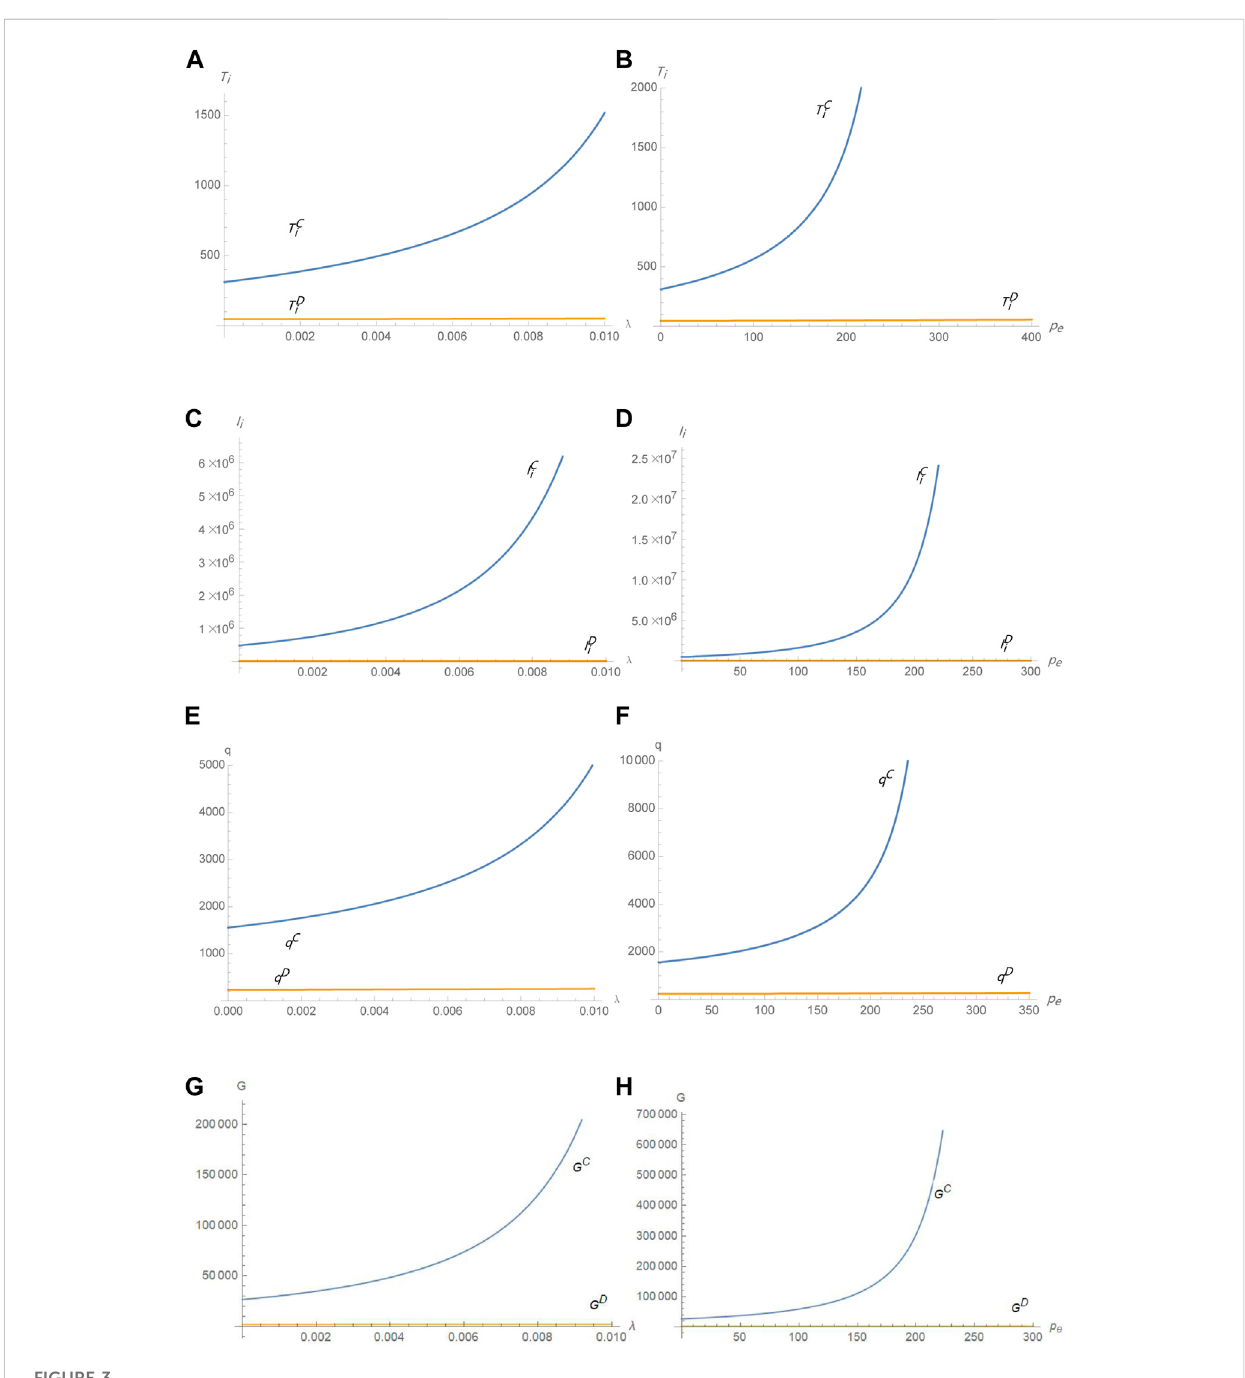
FIGURE 3 Impact of decision-making on the optimal